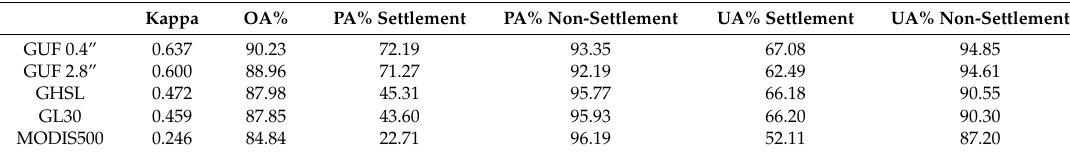
Table 1. Accuracy assessment results derived based on ~900,000 reference points labelled by crowd-sourcing via photointerpretation of 2015 VHR imagery from Google